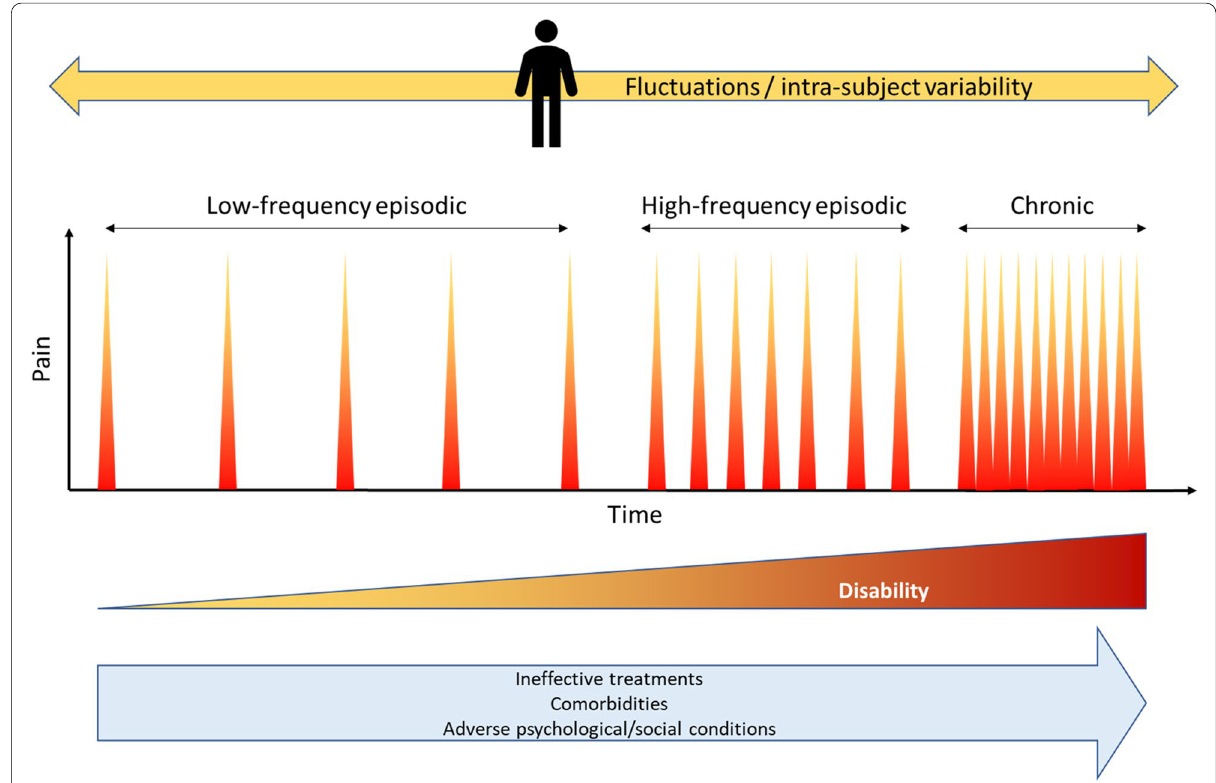
Fig. 1 Schematic representation of migraine patterns. Those patterns can change and revert throughout patients’